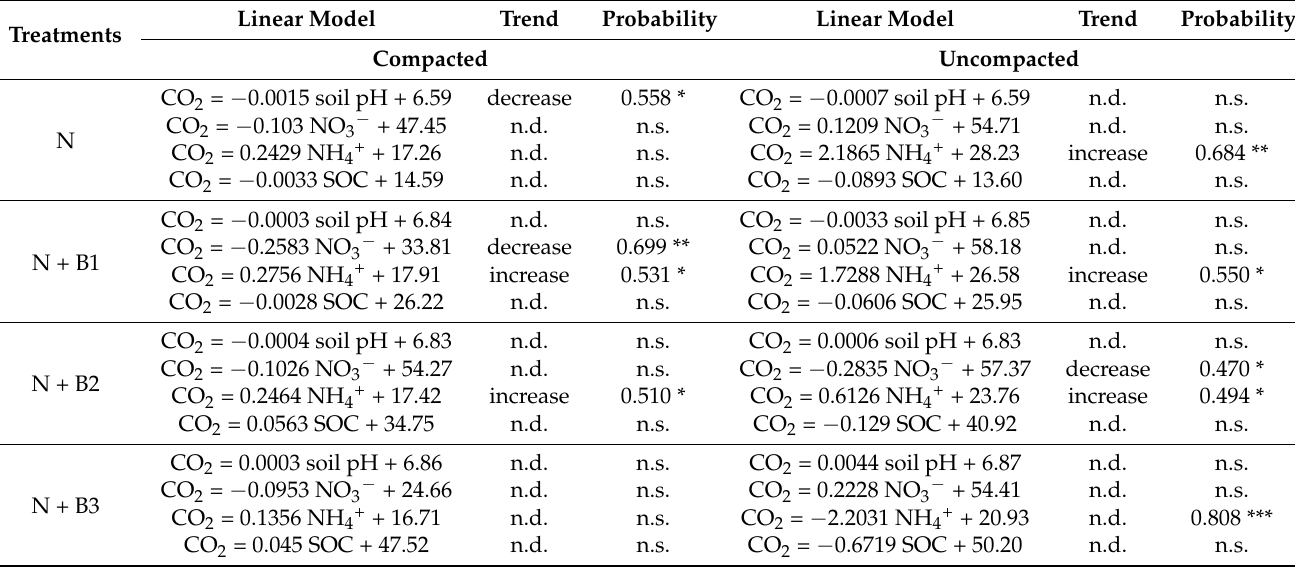
Table 5. Simple regression models between key soil parameters and CO 2